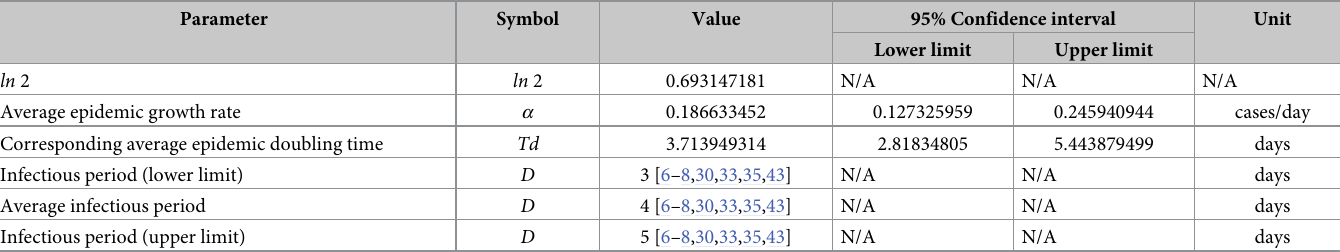
Table 3. Final list of parameters estimates used to calculate the basic reproduction number for bubonic plague using Eq 1. Parameter